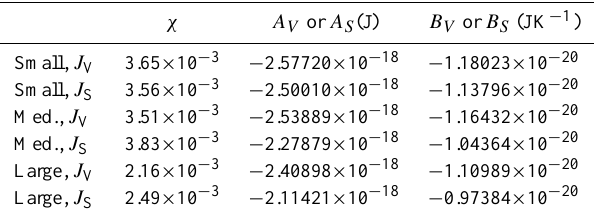
Table 1. Parameters resulting from separate model fits to small, medium and large aerosols, assuming only volume or surface nu- cleation. The quality of fit parameter χ has been defined by Earle et al. (2010).